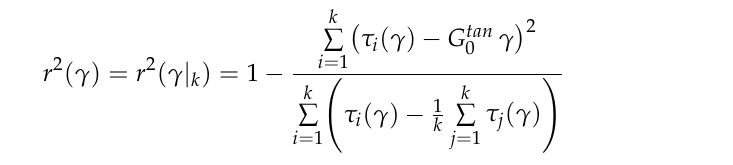
Figure 12. Summary of the onset and saturation points of significant non-linearity for the 12- configuration